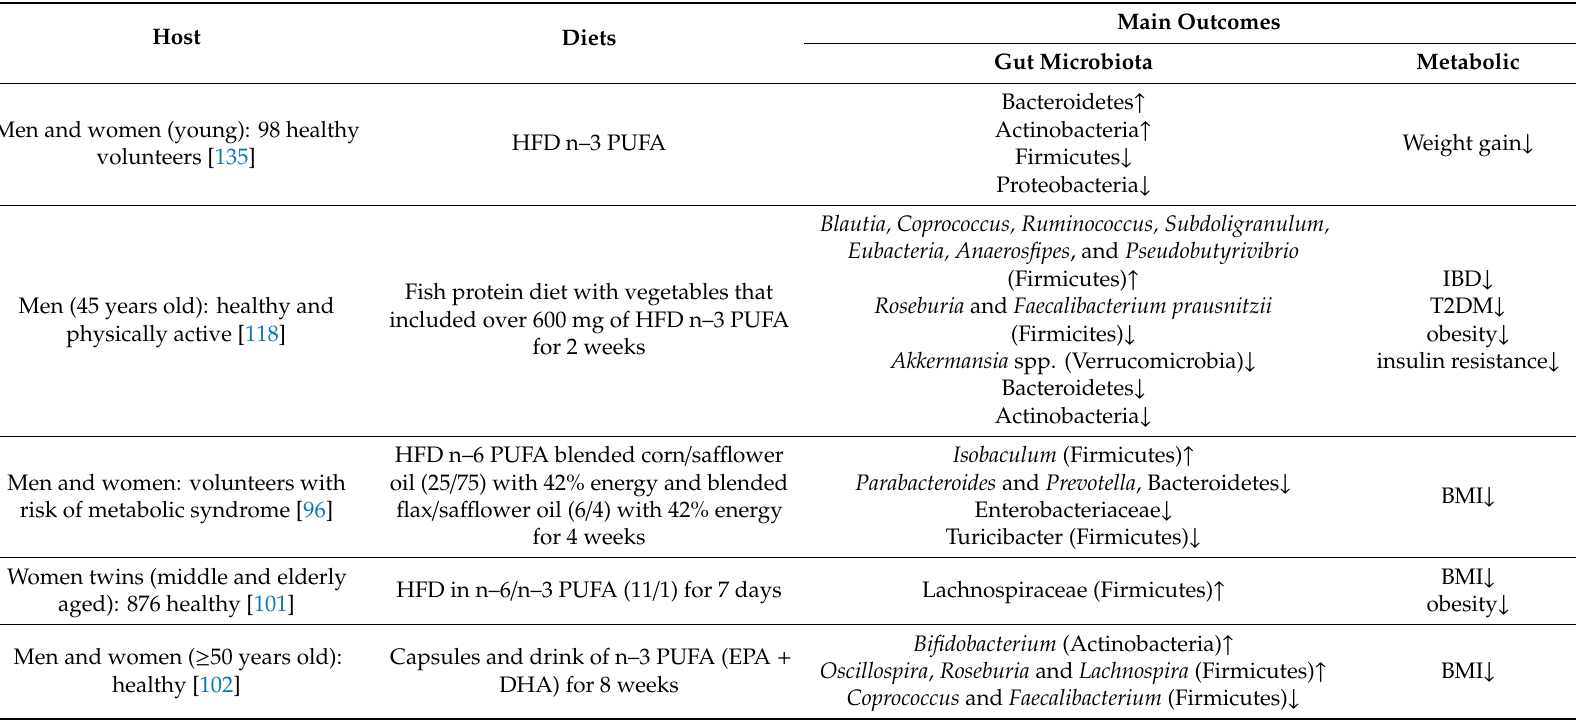
Table 6. E ff ects of PUFA intake on gut microbiota composition and metabolic outcomes in